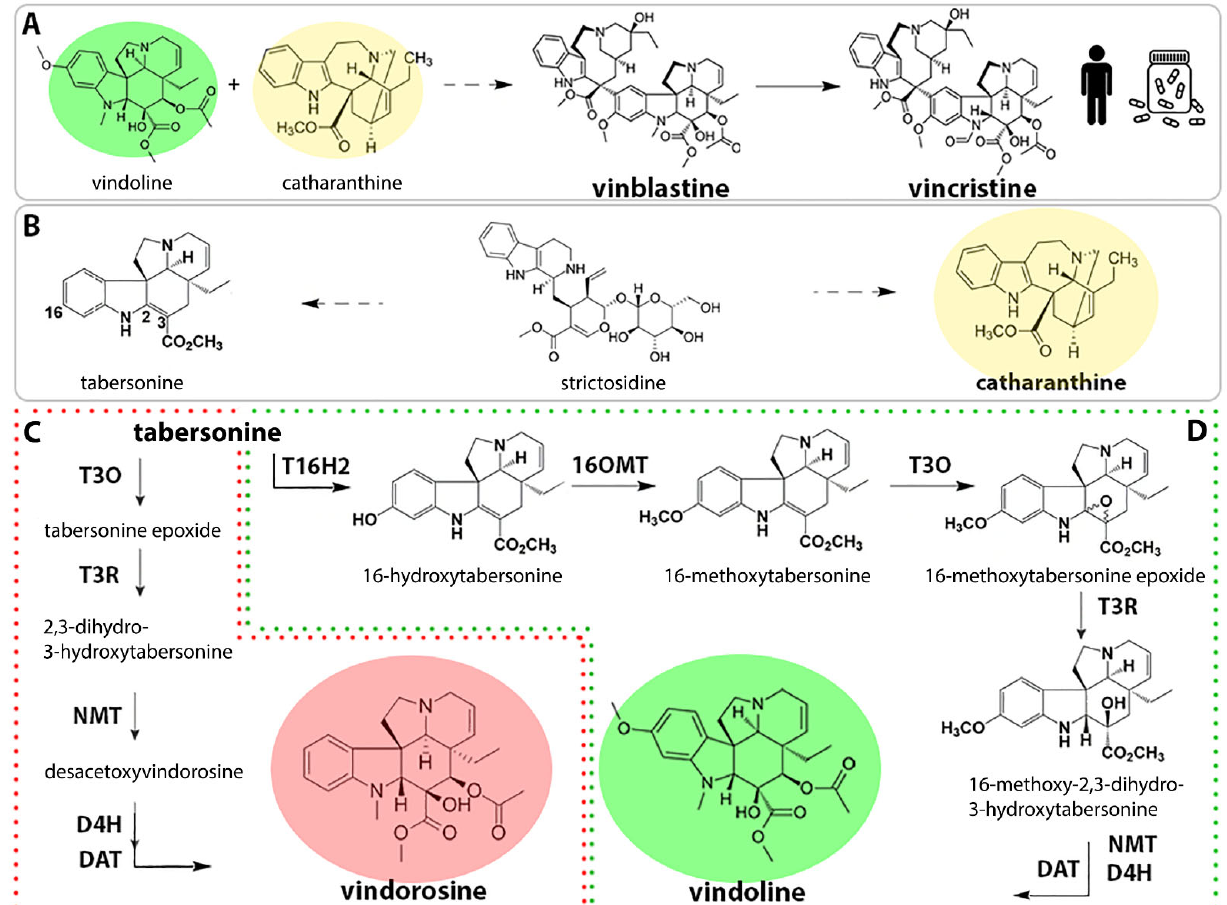
Figure 1. Vinblastine and vincristine production via semi ‐ synthetic synthesis. ( A ) Illustration of the semi ‐ synthetic synthesis of vinblastine and vincristine. ( B ) Tabersonine and catharanthine biosynthesis from strictosidine. ( C , D ) Tabersonine bioconversion in planta ( C ): by ‐ product vindorosine biosynthesis. ( D ): vindoline biosynthesis). Solid line: one enzymatic step, discontinuous line: more than one enzymatic step.